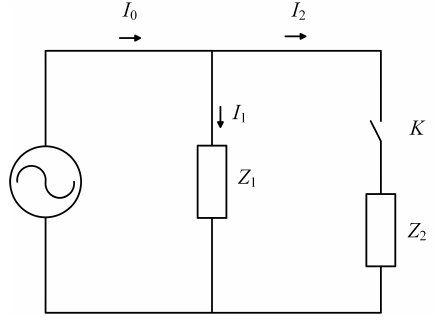
Figure 1. The parallel circuit.